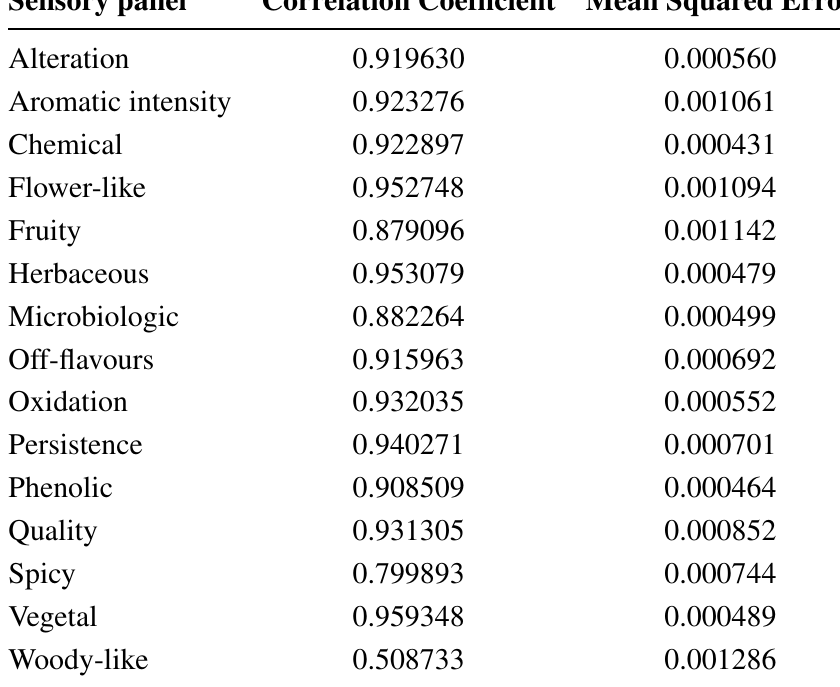
Table 3. Correlation coefficients and mean squared error values between the sensory panel descriptors and e-nose variables in